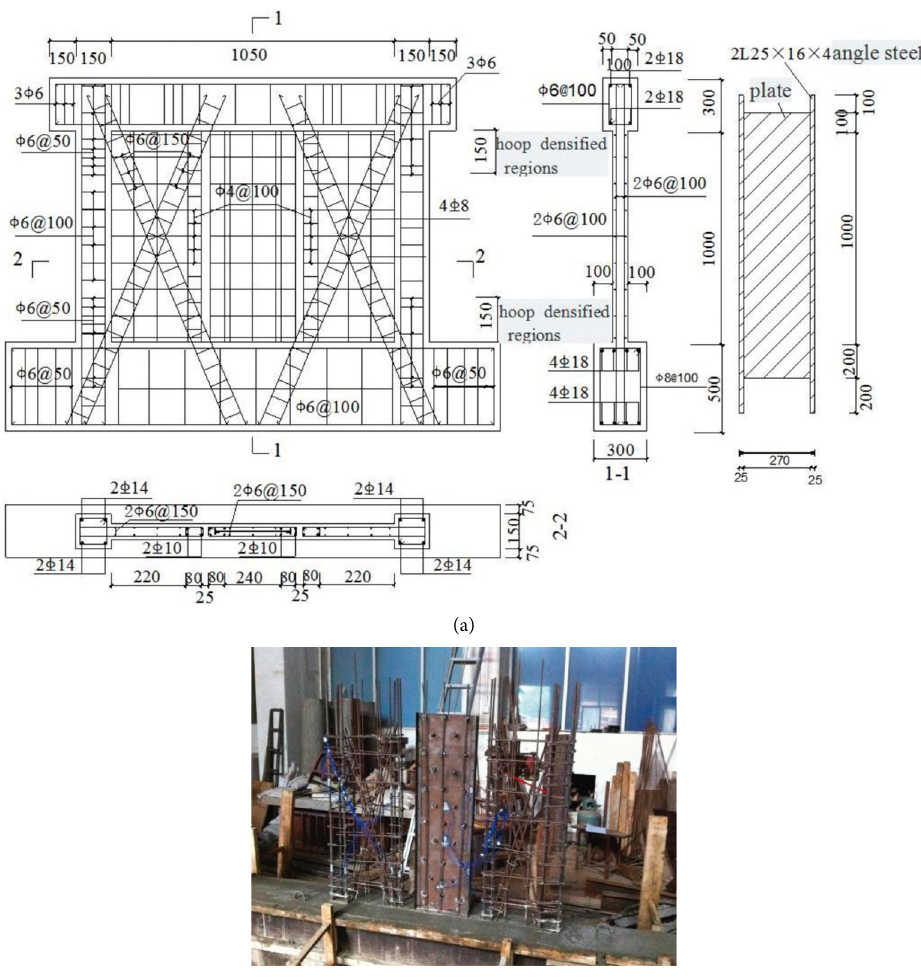
Figure 3: Reinforcement details and the actual model of HDNLSW. (a) Reinforcement details of HDNLSW. (b) Actual model of